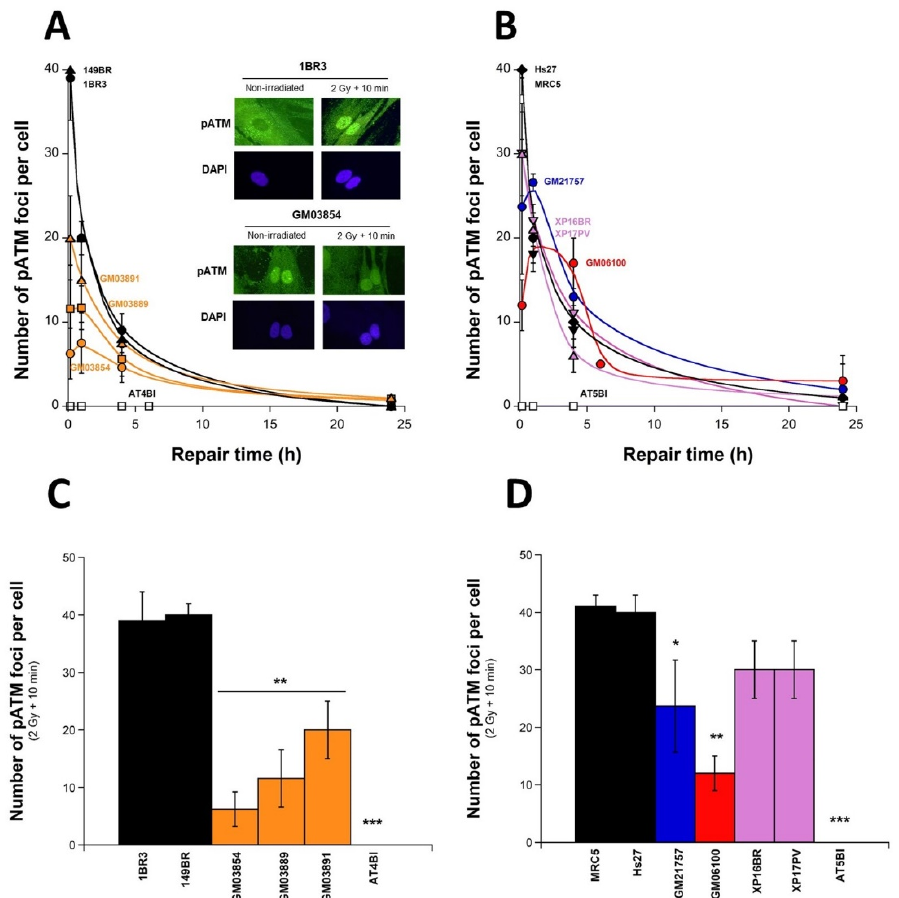
Figure 4. Kinetics of the appearance/disappearance of pATM foci in USH1 fibroblasts: The number of pATM foci was plotted against post-irradiation time. Data were obtained from the radioresistant controls 1BR3 and 149BR, the hyper-radiosensitive ATM -mutated AT4BI, and the three USH1 (GM03854, GM03889, and GM03891) fibroblast cell lines ( A ), and from the radioresistant controls MRC5 and Hs27, the hyper-radiosensitive ATM -mutated AT5BI, the HD (GM21757), the TSC (GM06100), and two XPD (XP16BR and XP17PV) fibroblast cell lines ( B ). Panels ( C , D ) represent the 10 min post-irradiation data only. Each plot represents the mean ± SEM of three replicates. Data were fitted to Bodgi’s formula [36]. The insert shows a representative illustration of DAPI-stained nuclei and pATM foci observed at 10 min post-irradiation (2 Gy X-rays) in the indicated cell lines. Asterisks represent the statistically significant differences from radioresistant controls, expressed as p -values (1, 2, and 3 asterisks correspond to p < 0.05, p < 0.01, and p < 0.001, respectively).